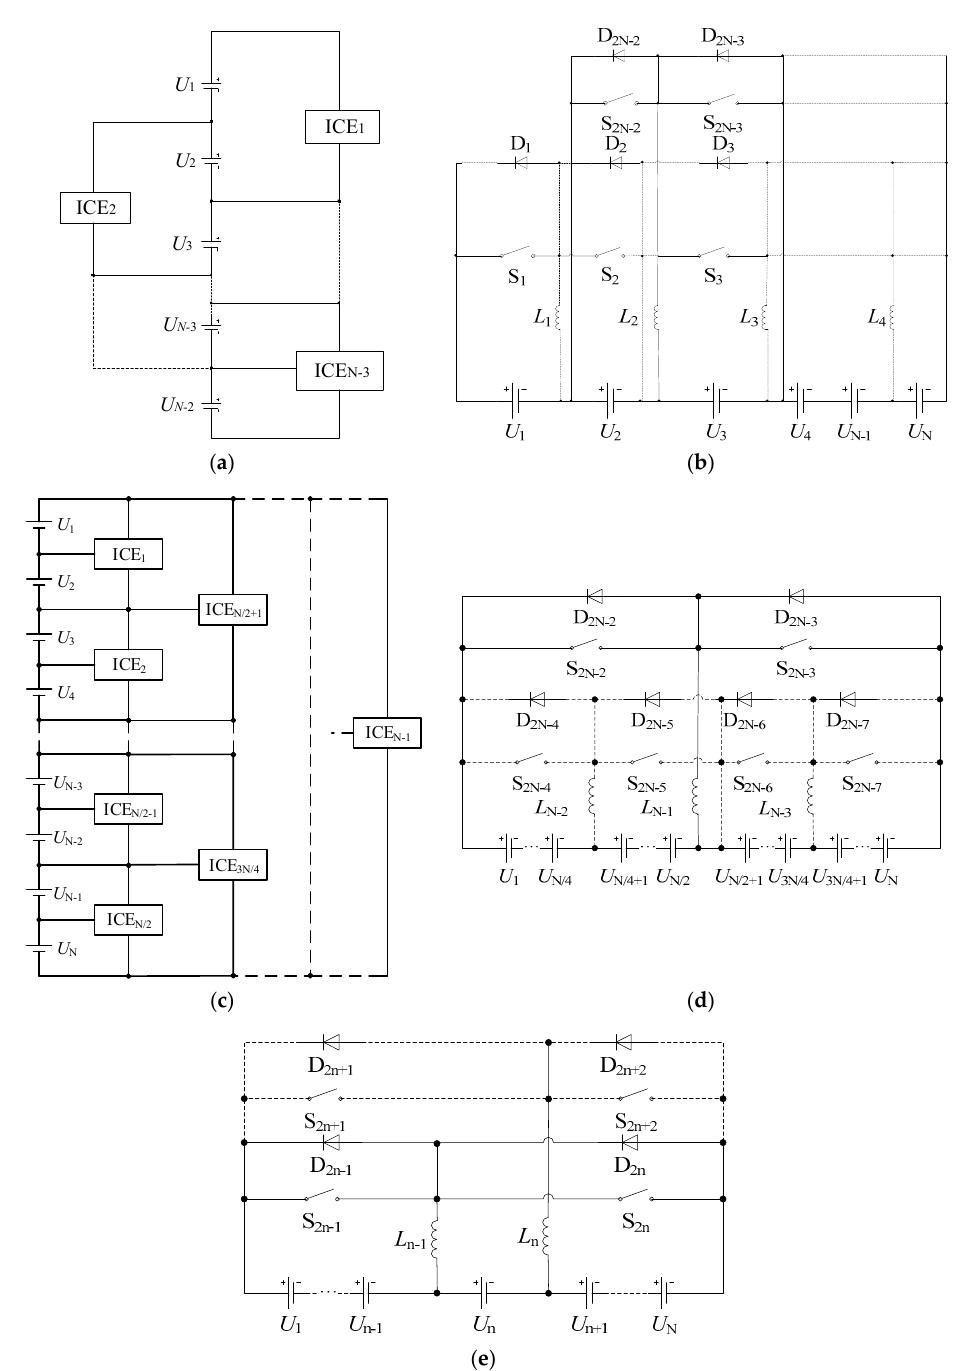
Figure 3. Equalisation system control structure of the cell-to-cell scheme. ( a ) The series-based battery equalisation system; ( b ) the series-based battery equalisation topology; ( c ) the layer-based battery equalisation system; ( d ) the layer-based battery equalisation topology; and ( e ) the multi-staggered battery equalization